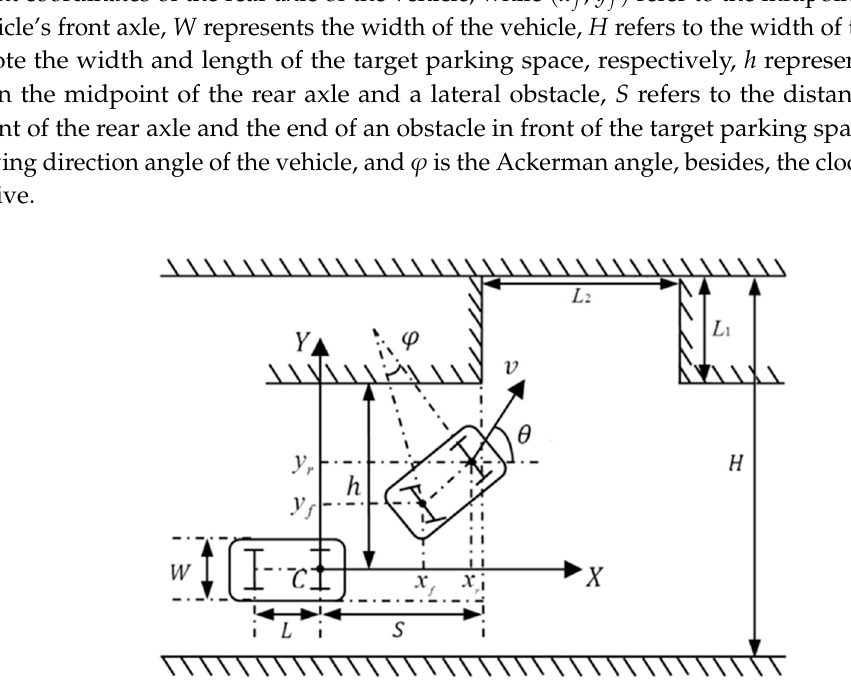
Figure 2. Simplified Vehicle Model for Parking.